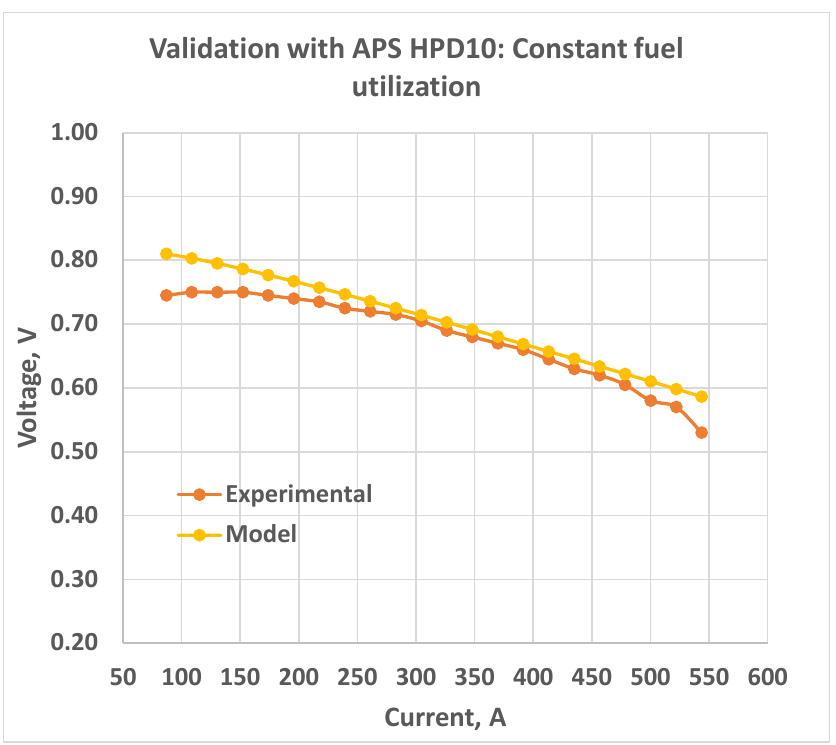
Figure 4. Validation results for the constant fuel utilization operation; mean absolute relative error =